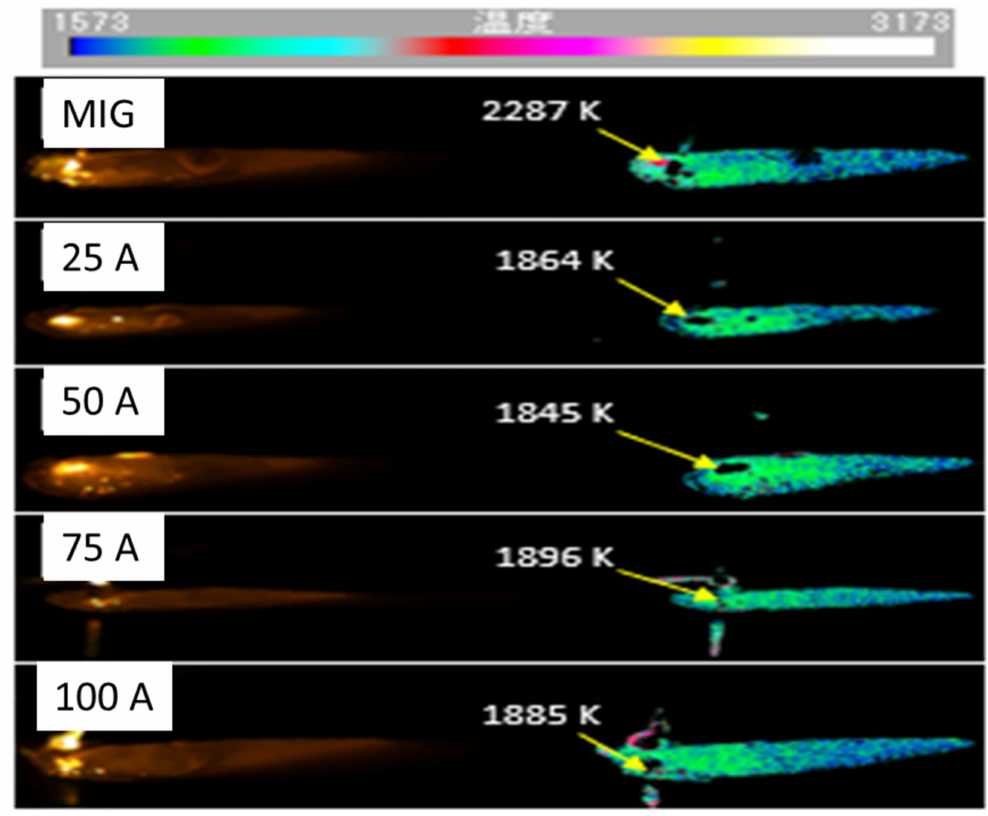
Figure 3. Weld pool peak temperature in conventional MIG welding for 0 A plasma current, 25 A plasma MIG welding, 50 A plasma MIG welding, 75 A plasma MIG welding and 100 A plasma MIG welding.